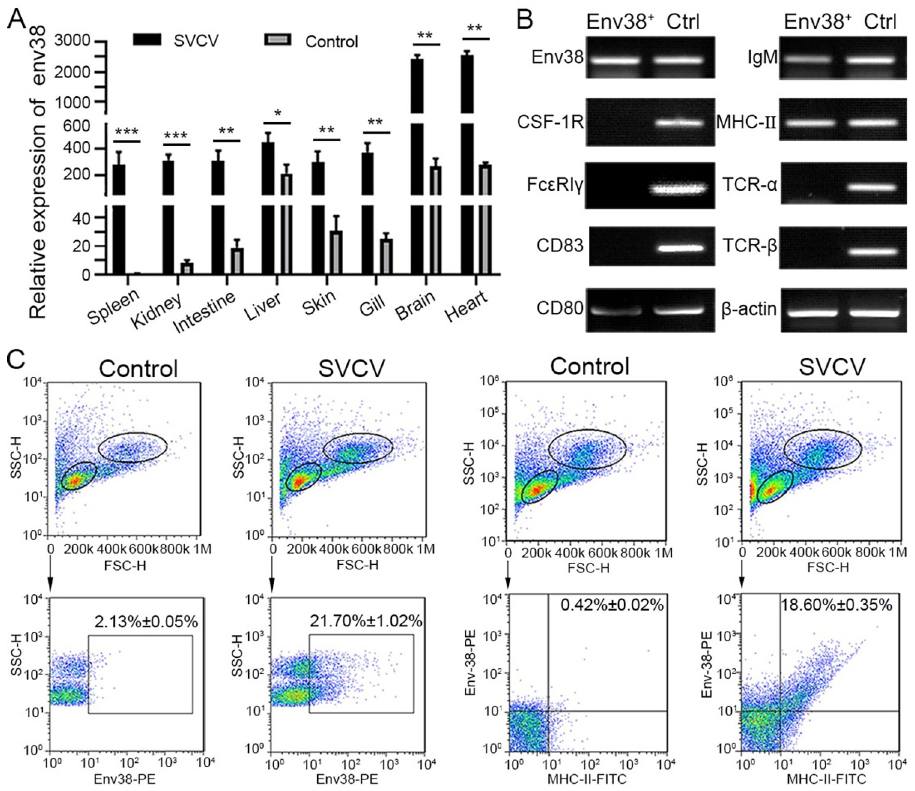
Fig 5. Detection of Env38 in tissues and cells in response to SVCV infection. (A) RT-qPCR analysis for the expression of env38 gene in spleen, head kidney, intestine, liver, skin, gill, brain and heart tissues of zebrafish stimulated with SVCV (10 5 TCID 50 ) or mock PBS (control) for 7 days. The expression of env38 mRNA in spleen in PBS treatment was arbitrarily set at 1. Negative control group was treated with mock PBS. Each sample was obtained from at least 10 fish. (B) Cellular distribution of Env38 on leukocytes from spleen, head kidney and peripheral blood of zebrafish stimulated with SVCV (10 5 TCID 50 ). The Env38 + APCs were sorted from the leukocytes by FCM and qualitatively examined by RT-PCR with a panel of cellular markers of various immune cells, including CSF-1R and Fc ε RI γ (markers of monocytes/macrophages), CD83 and CD80 (markers of dendritic cells), membrane IgM (markers of B lymphocytes), MHC-II (markers of antigen presenting cells) as well as TCR- α and TCR- β (markers of T lymphocytes). Total leukocyte sample was used as a control. (C) Flow cytometry analysis of the percentages of Env38 + cells and MHC-II + Env38 + cells in lymphatic and myeloid leukocytes from spleen, head kidney and peripheral blood of zebrafish stimulated with SVCV (10 5 TCID 50 ) for 7 days. The numbers above the outlined areas indicated the percentage of cells in each group. In control groups, zebrafish were i.p. with the same amount of mock PBS. In the RT- qPCR assay, PCRs were run in combination with the endogenous β -actin control. Error bars represent SEM. ( � p < 0.05; �� p < 0.01; ��� p < 0.001; ns, no significant